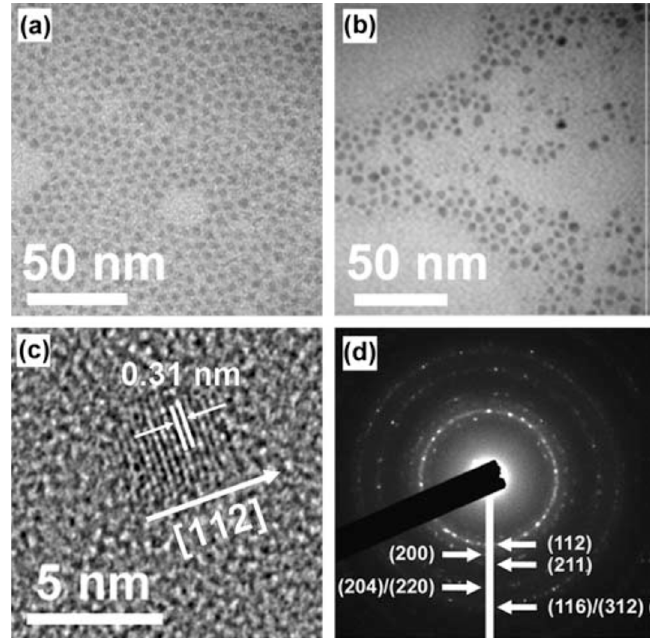
Figure 4. TEM images of the CuInS 2 QDs grown with excess Na 2 S for 1 h at ( a ) 150 _C and ( b ) 170 _C. ( c ) HRTEM image of the as-prepared CuInS2 QDs grown at 150 _C for 1 h with visible lattice fringes. ( c ) HRTEM image of the as-prepared CuInS 2 QDs grown at 150 ◦ C for 1 h with visible lattice fringes. ( d ) Selected-area electron diffraction pattern of the 150 °C CuInS 2 QDs. The arrows point to where the ( d ) Selected-area electron di ff raction pattern of the 150 ◦ C CuInS 2 QDs. The arrows point to where the vertical white line crosses the crystal face rings. [22]. vertical white line crosses the crystal face rings.